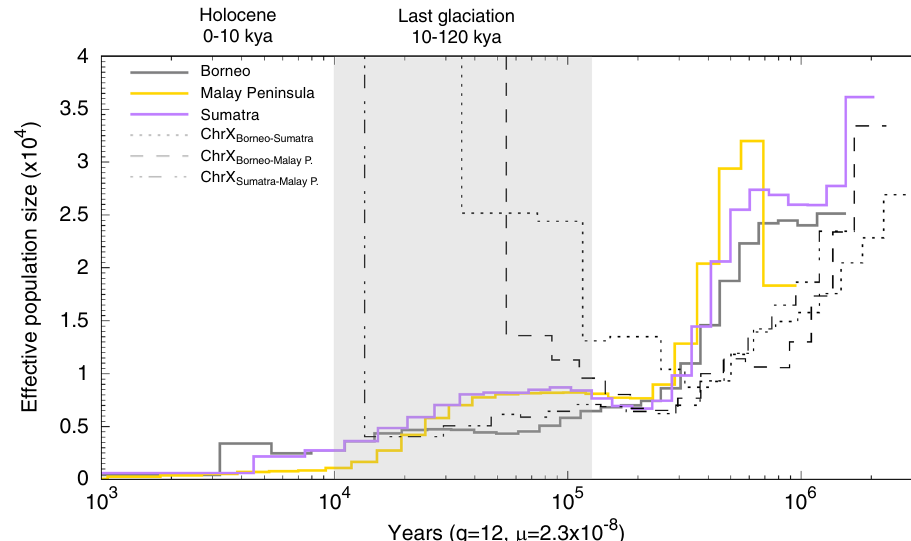
Fig. 2 Population history and timing of population divergence for Sumatran rhinoceros ( Dicerorhinus sumatrensis ). Thick coloured lines depict temporal fl uctuations in effective population size ( N e ) for the three populations with each coloured line representing one individual from each population. Dotted/ dashed black curves represent the pseudodiploid sex chromosomes (i.e., X chromosome) used to infer pairwise population divergence times, with the curves going to in fi nity at the respective time of divergence. The X-axis corresponds to time before present in years on a log scale, assuming a substitution rate ( μ ) of 2.34 × 10 − 8 substitutions/site/generation 30,82 and a generation time ( g ) of 12 years 76 . The y -axis corresponds to N e . The grey rectangle depicts the last glaciation. Bootstrap tests were conducted with 100 replicates (Supplementary Fig.